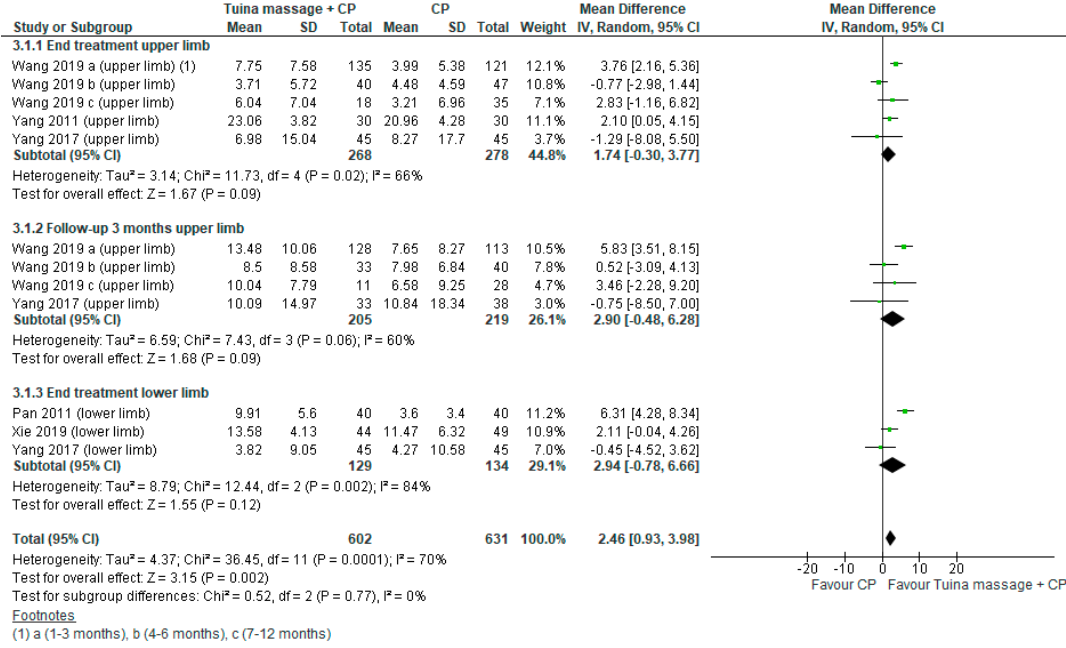
Figure 2. Forest plot of comparison Tuina massage plus conventional physiotherapy (CP) versus CP for motor function evaluated by Fugl Meyer Assessment Scale